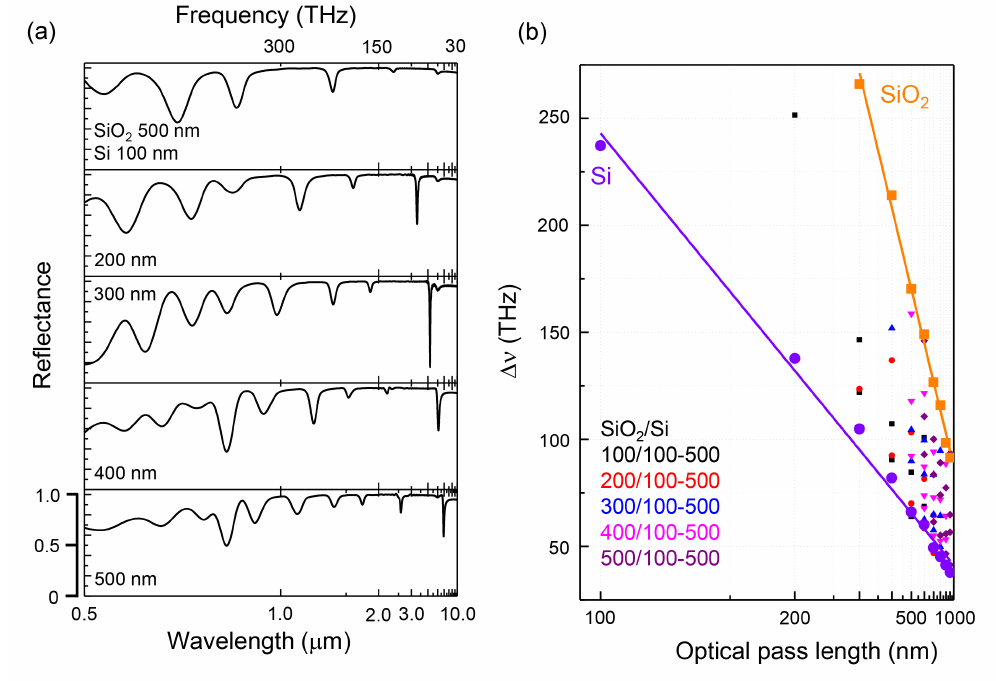
Figure 5. Finite difference time domain (FDTD) simulations (Lumerical FDTD Solutions) of multilayered black metals. ( a ) Reflection spectra of the SiO 2 500 nm and a variable Si layer with thickness spanning 100–500 nm. ( b ) The FSR of the SiO 2 and Si layers with a range of thicknesses from 100 to 500 nm; the bounding lines represent homogeneous Si and SiO 2 dielectric spacer